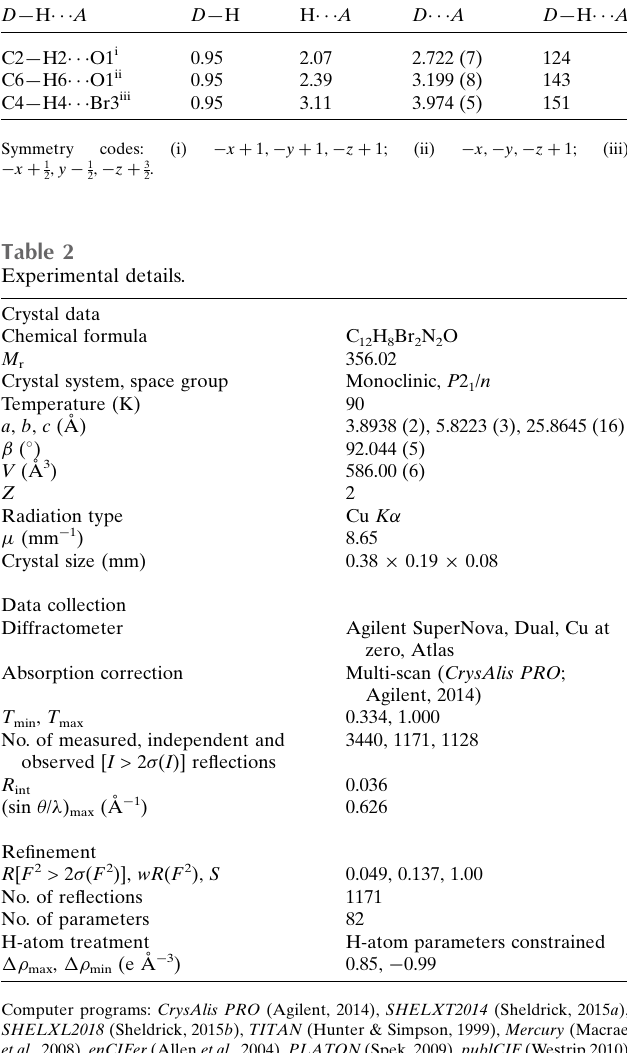
Table 1 Hydrogen-bond geometry (A˚ , (cid:3) ).